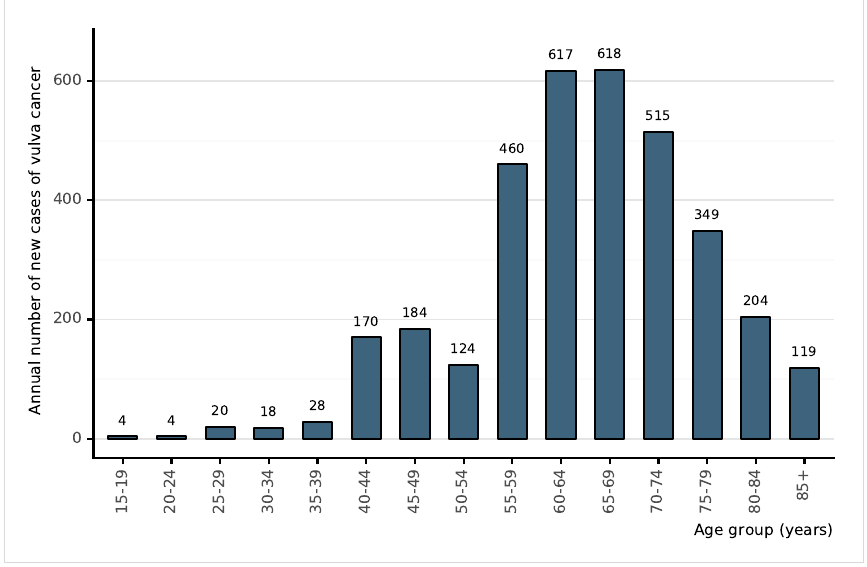
Figure 22: Annual number of new cases of vulva cancer in India (estimates for